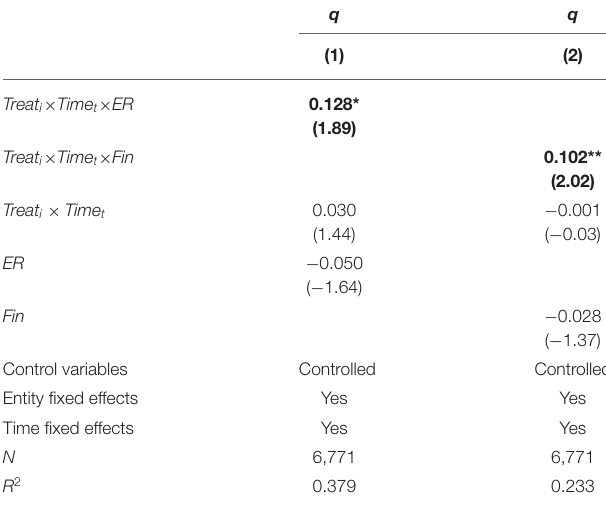
TABLE 4 | Analysis of regulatory